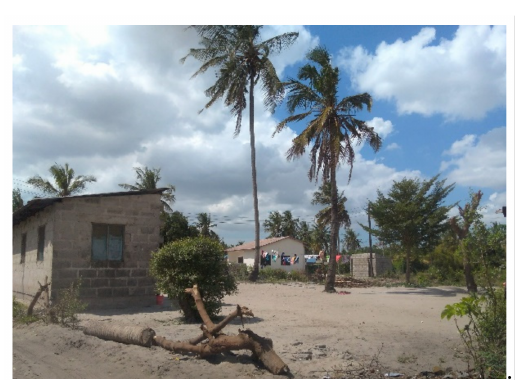
Figure 3. Single trees between residential plots that remained after clearance of the area for house development (photo: Saskia Wolff